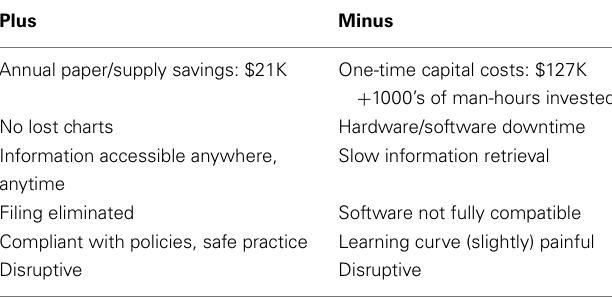
Table 8 |The “balance sheet” for our radiation oncology